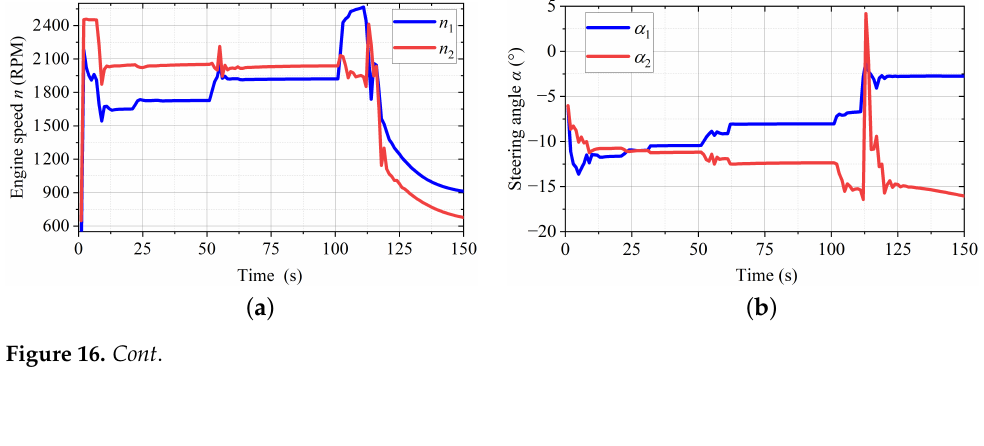
Figure 15. Thrust allocation results of control signals. ( a ) Thrust allocation in y direction; ( b ) Thrust allocation in x direction.